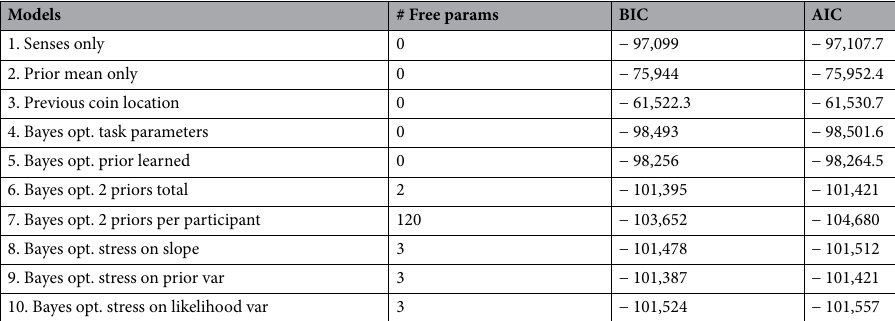
Table 1. Model performance. Represented, for each model, are the number of free (fitted) parameters, the Bayesian Information Criteria (BIC) and the Akaike Information criteria (AIC). The results were obtained using the full dataset. Lower values of BIC and AIC (here, more negative) suggest a better model fit. Free Params = Free